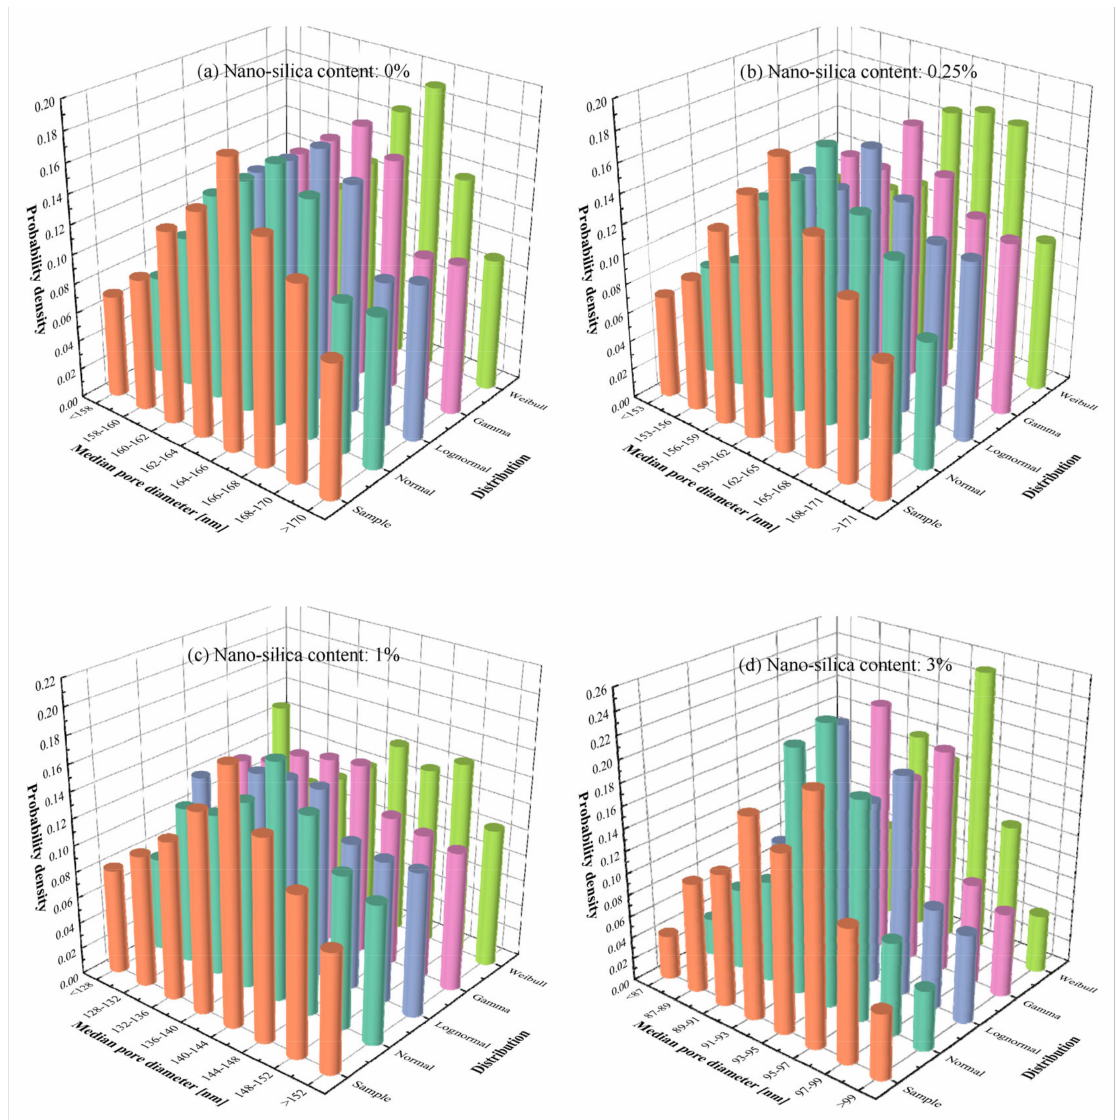
Figure 10. The distribution laws of four distributions and measured median pore radius. In this part, the possible value range of the cumulative volume of pore size smaller than 0.1 µ m is divided into seven or eight intervals. The distribution laws of potential probability distributions and measured V D < 0.1 µ m at four NS additions are shown in Figure 11. When the NS additions are 0, 0.25%, 1%, and 3%, the corresponding maximum probabilities of measured V D < 0.1 µ m are in the intervals of 33~34%, 34~35%, 35~36%, and 51~52%, respectively. Additionally, the probabilities are 0.21, 0.17, 0.18, and 0.20, respectively. In general, for the V D < 0.1 µ m , the distribution law of normal distribution has a high similarity with the sample distribution. However, the lognormal, Gamma, and Weibull distributions are different from the sample distribution law, especially the Weibull